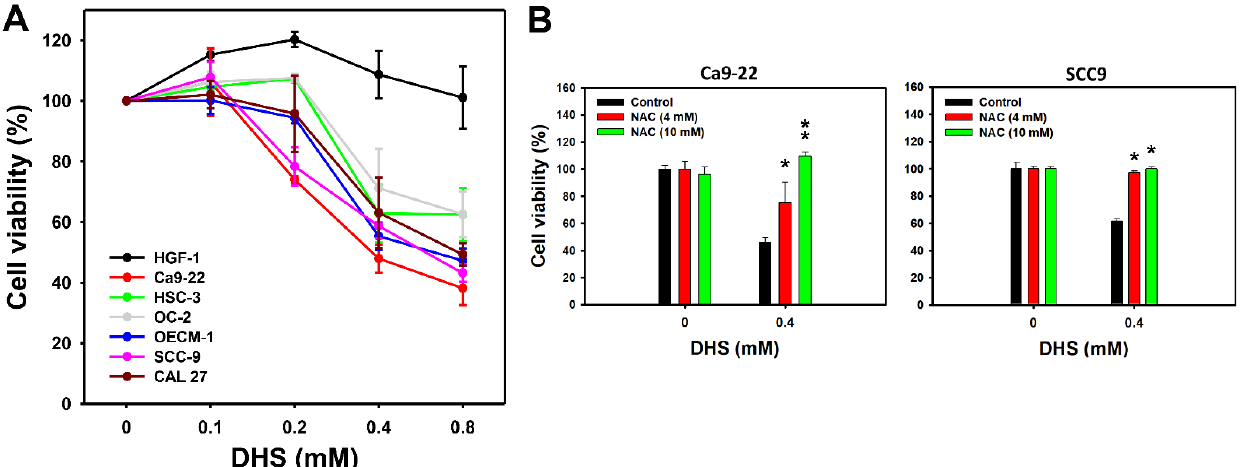
Figure 1. DHS kills oral cancer cells. ( A ) MTS assay (48 h) for DHS-treated oral cancer and non-malignant oral cells. Six oral cancer cell lines (Ca9-22, SCC-9, OECM-1, CAL 27, OC-2, and HSC-3) and one non-malignant oral cell line (HGF-1) were chosen. Cells were treated with DHS (0 (vehicle containing 0.08% DMSO), 0.1, 0.2, 0.4 and 0.8 mM) for 48 h. ( B ) Recovery of cell viability of DHS-treated Ca9-22 and SCC-9 cells by NAC. Cells were pretreated with NAC (10 mM for 1 h) or not. They were then treated with 0.4 mM DHS or with the vehicle for 0 and 48 h. Data = means ± SDs ( n = 3 independent experiments). * and ** indicate significant differences between drug treatments (NAC/DHS) and DHS ( p < 0.05 and 0.01, respectively).